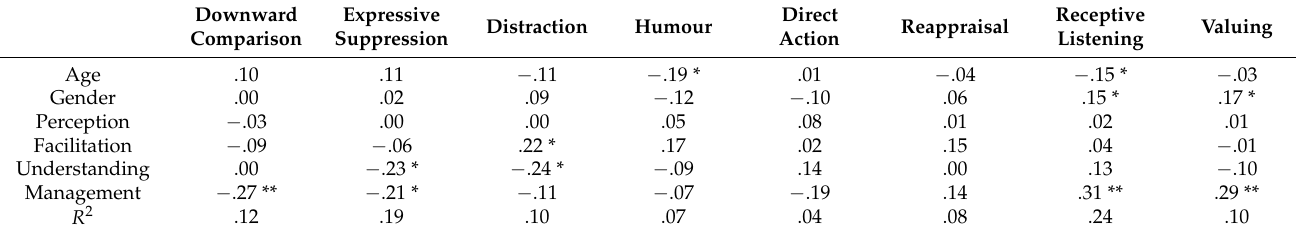
Table 3. Standardized regression coefficients from multiple regressions predicting each